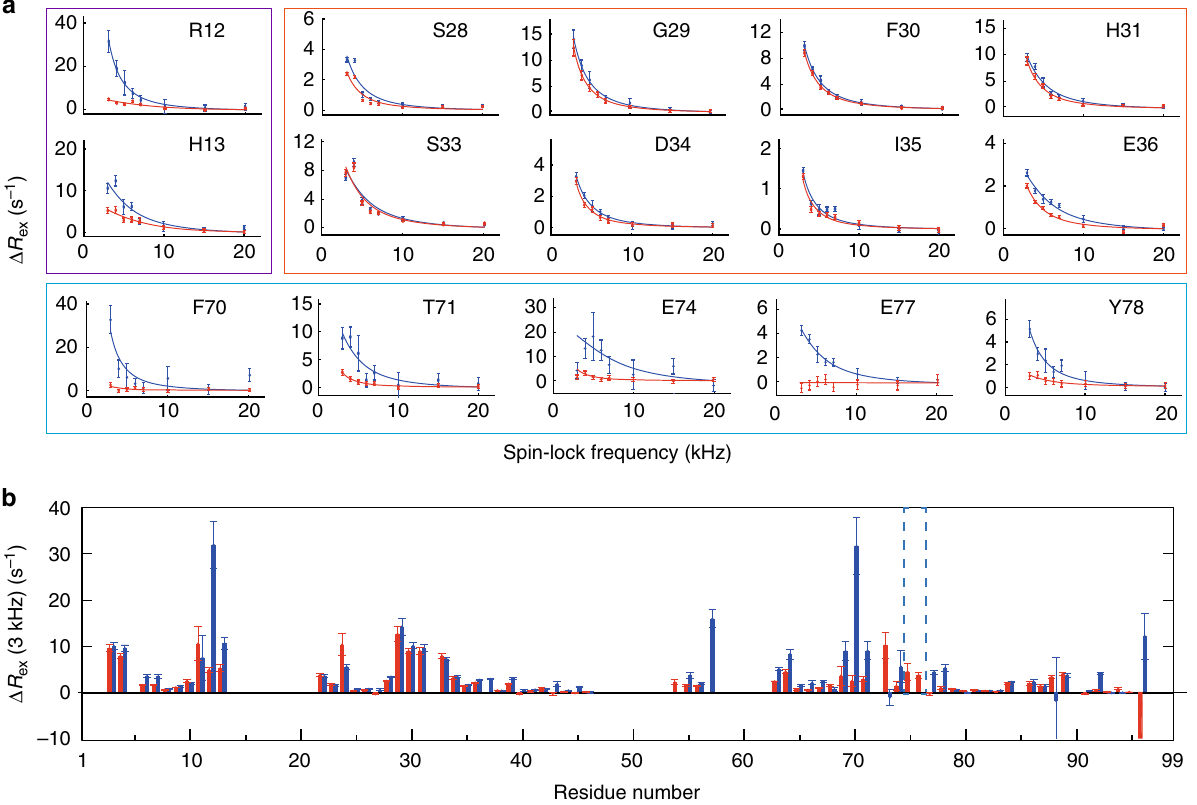
Fig. 3 Conformational exchange of β 2m probed by relaxation dispersion experiments. Selected examples of 15 N R 1 ρ relaxation dispersion curves for wt (red) and D76N (blue) β 2m. a The purple, orange, and blue rectangles show respectively residues located at the end of the A-strand, in the CD-loop and EF-loop. Best Lorentzian fi ts are depicted with solid lines. The difference between 15 N R 1 ρ rates at 3 kHz and the fi tted values at 20 kHz spin-lock fi eld are depicted versus the sequence in b . Error bars (s.d.) were obtained from 1000 Monte Carlo